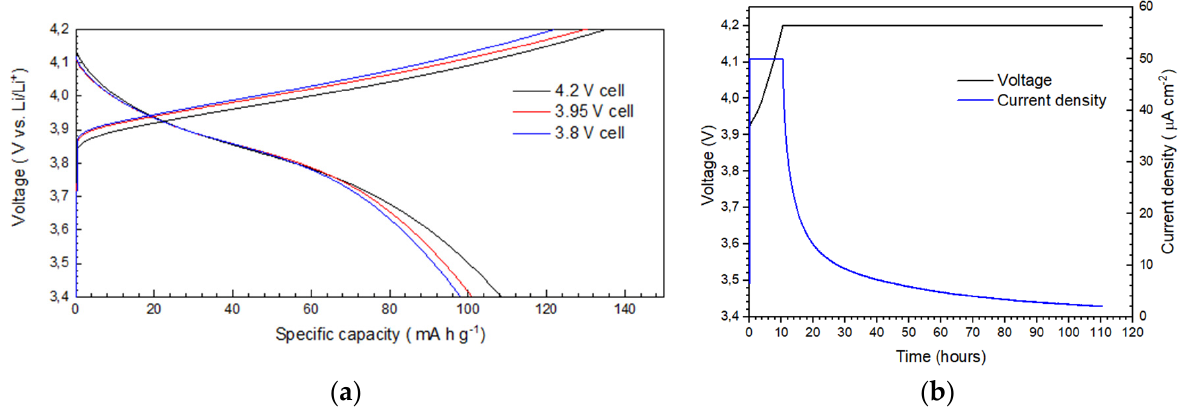
Figure 3. Electrochemical characterization of all three LLZO-based ASBs showing reproducible cell performance in the first cycle ( a ) and example of the ex-situ preparation of the 4.2 V LLZO-based cell with a holding time of 110 h to allow equilibration of Li-concentration within the mixed cathode ( b ).